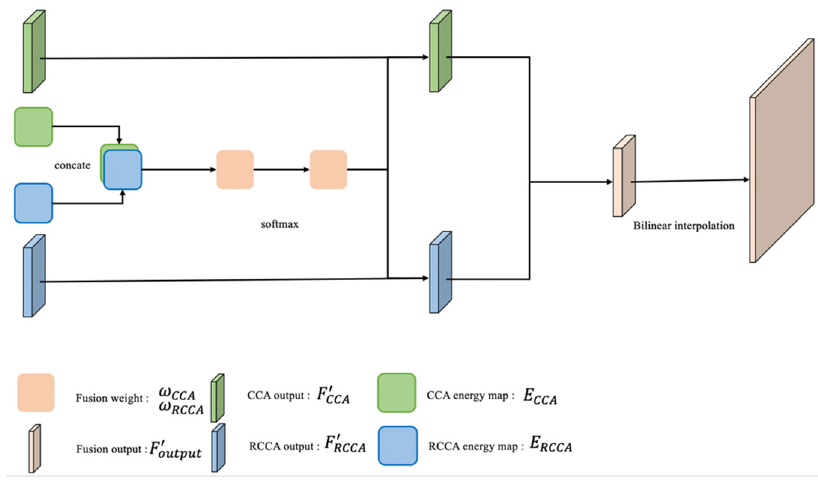
Figure 15. The structure of the output part.